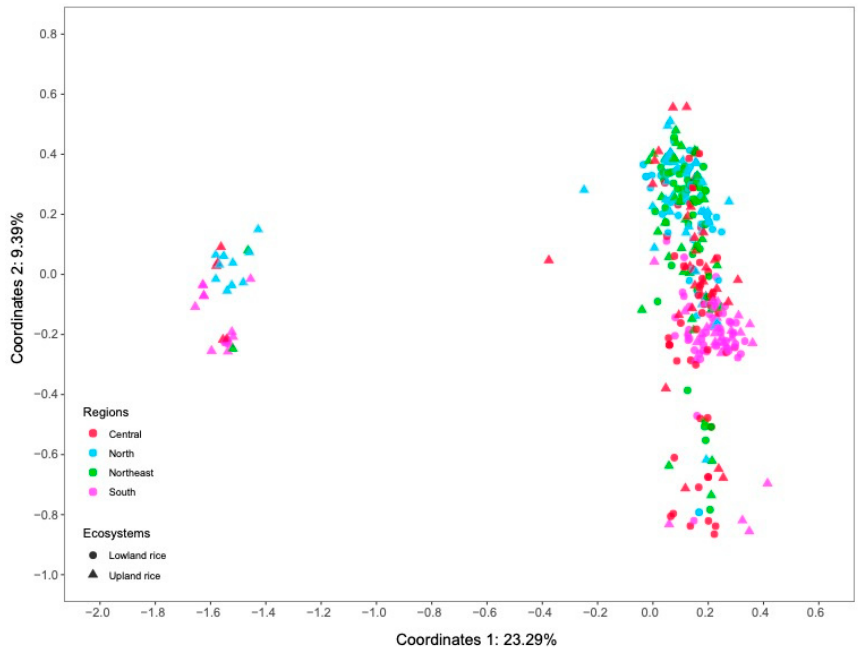
Figure 5. Principal coordinate analysis (PCoA) ordination based on the Nie distance matrix of the genotypes from 75 SNP markers comparing 365 samples. The PCoA is colored according to the regional populations. The circle and triangle symbols depict lowland and upland ecosystems, respectively. The percentage of the variation coordinate is indicated on the axes.